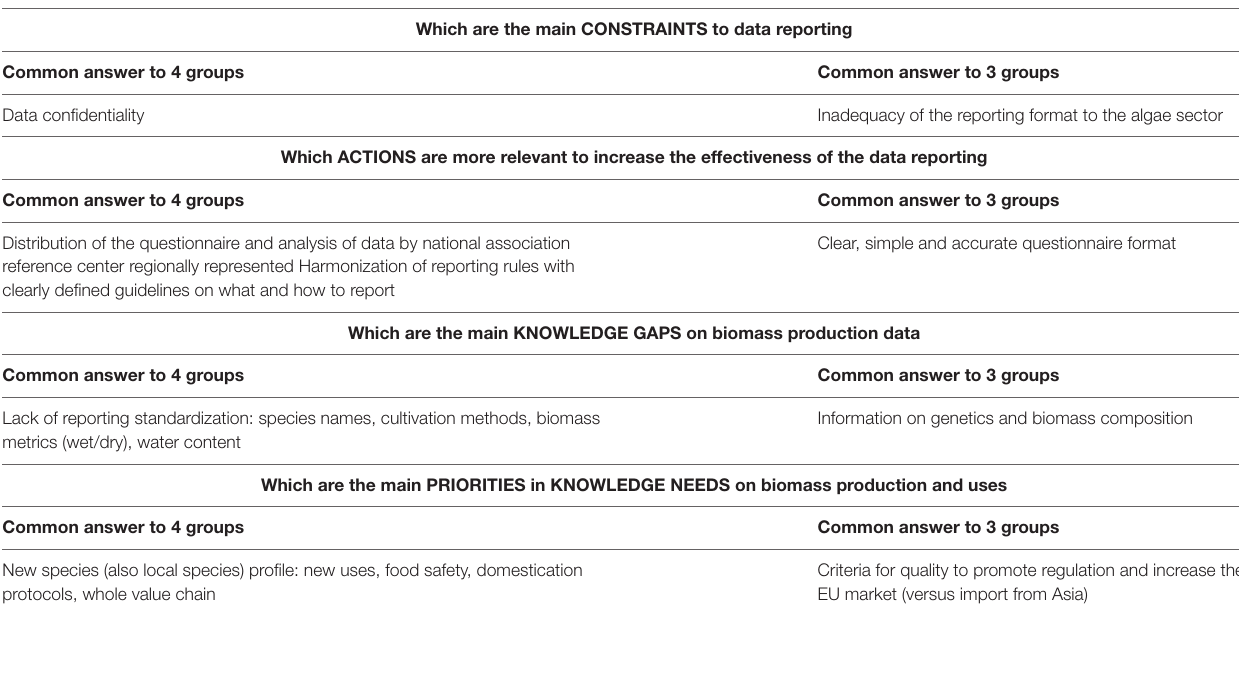
TABLE 1 | Results of the workshop discussion rounds: answers common to 4 and 3 of the